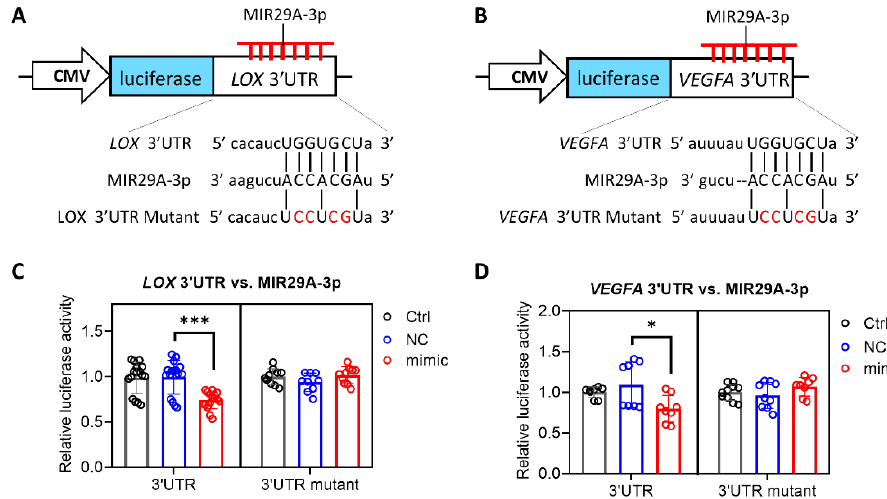
Figure 4. Overexpression of MIR29A suppresses the gene and protein expression of LOX , LOXL2 , and VEGFA . Human HCC HepG2 cells were treated with transfection reagent as a control (Ctrl), miR negative control sequence (NC), or MIR29A -3p mimic (mimic). Then, cell specimens of at least four independent experiments were processed for the detection of gene and protein expression levels of LOX ( A , B ), LOXL2 ( C , D ), and VEGFA ( E , F ) by using qPCR and western blot. 18S in qPCR was used for the normalization gene, while GAPDH in western blot served as the loading control. * p < 0.05, ** p < 0.01, *** p < 0.001 between the indicated groups.